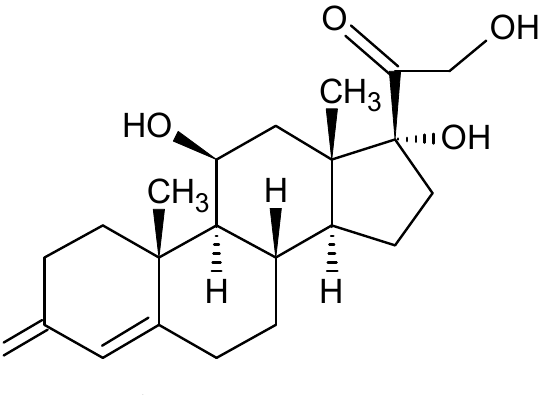
Figure 1. Cortisol structure.